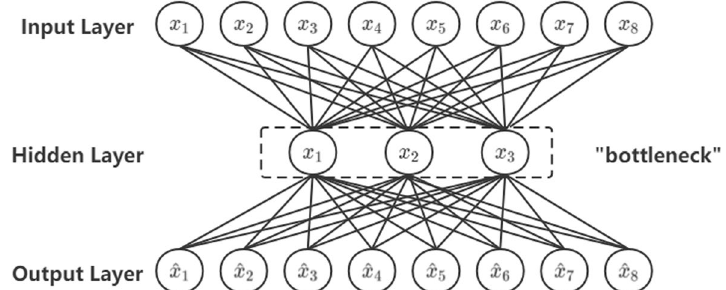
Fig. 6 Classical structure of AE